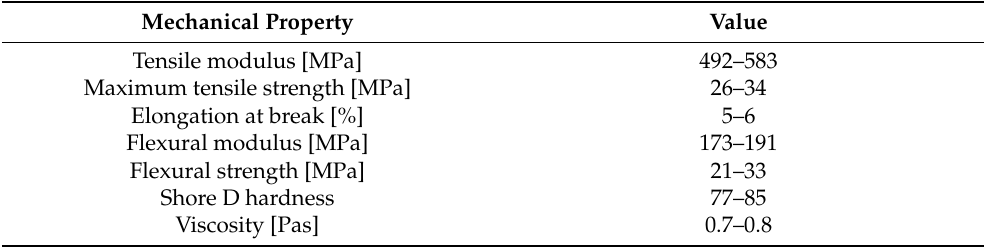
Figure 1. Design of the abutment die and zirconia crown: ( a ) schematic diagram of the abutment die and crown (mesial aspect); ( b ) zirconia crown design. Table 1. Mechanical properties of the resin die material.